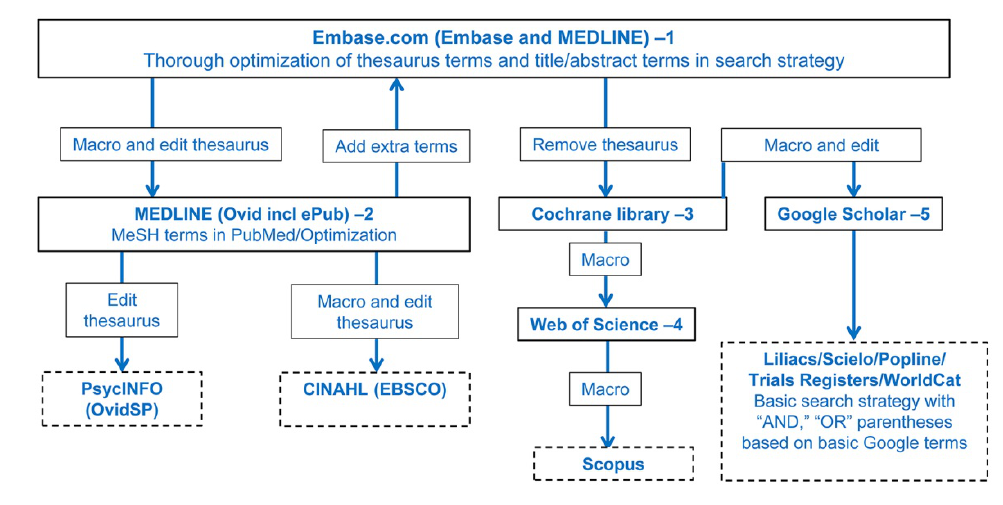
Figure 2 Schematic representation of translation between databases used at Erasmus University Medical Center